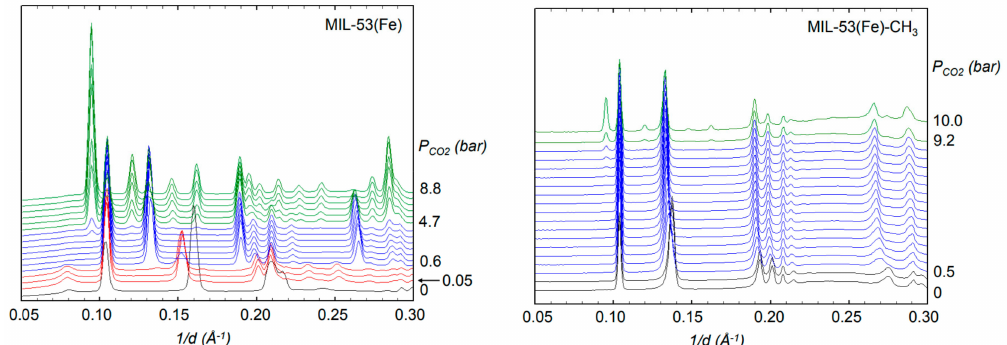
Figure 16. CO 2 adsorption on MIL-53(Fe) –X (X = –CH 3 ) at 230 K followed by PXRD. Spectra were recorded at di ff erent pressures. Black: anhydrous closed pores form; red: intermediate form; blue: NP form and green: LP form [134].